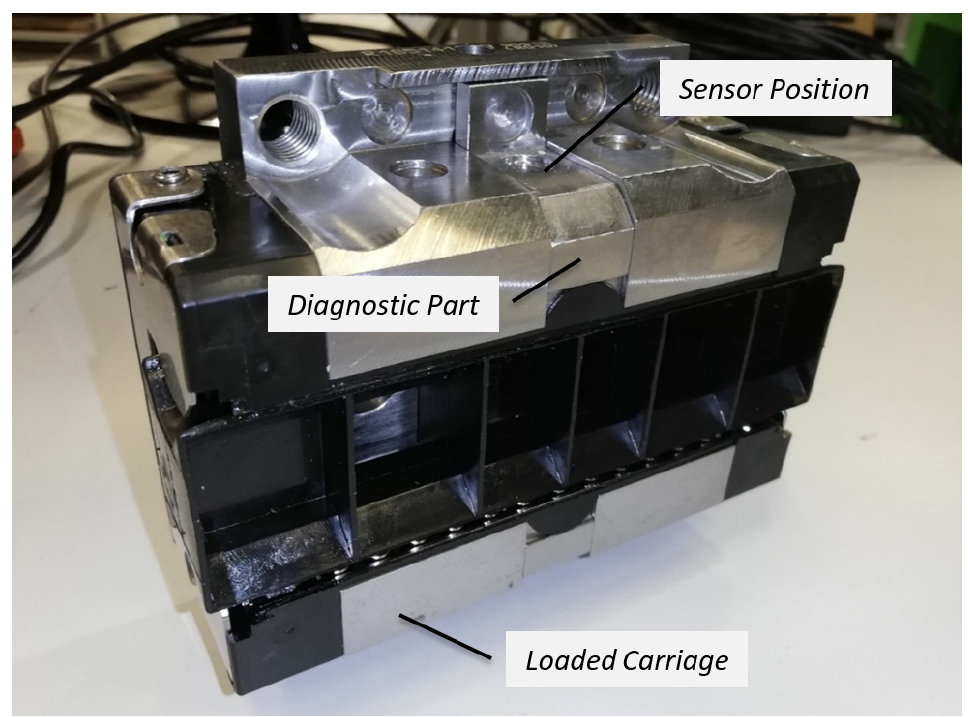
Figure 3. The functional sample with the integrated diagnostic part. Table 1. Parameters of Bosch Rexroth linear rolling guide.